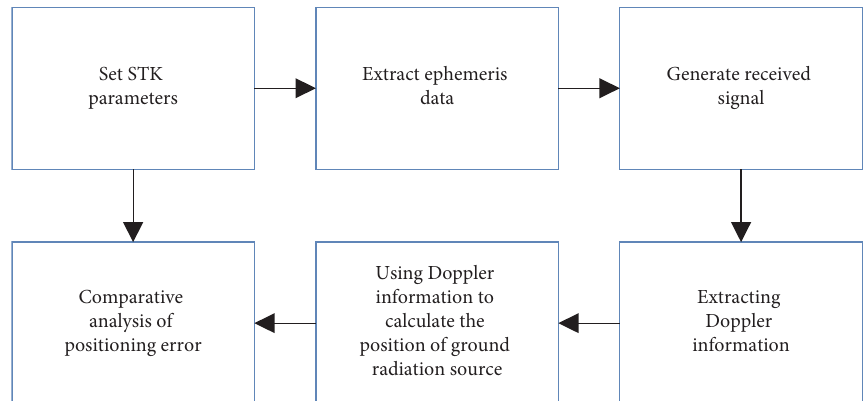
Figure 2: Single-star passive positioning simulation fow chart.